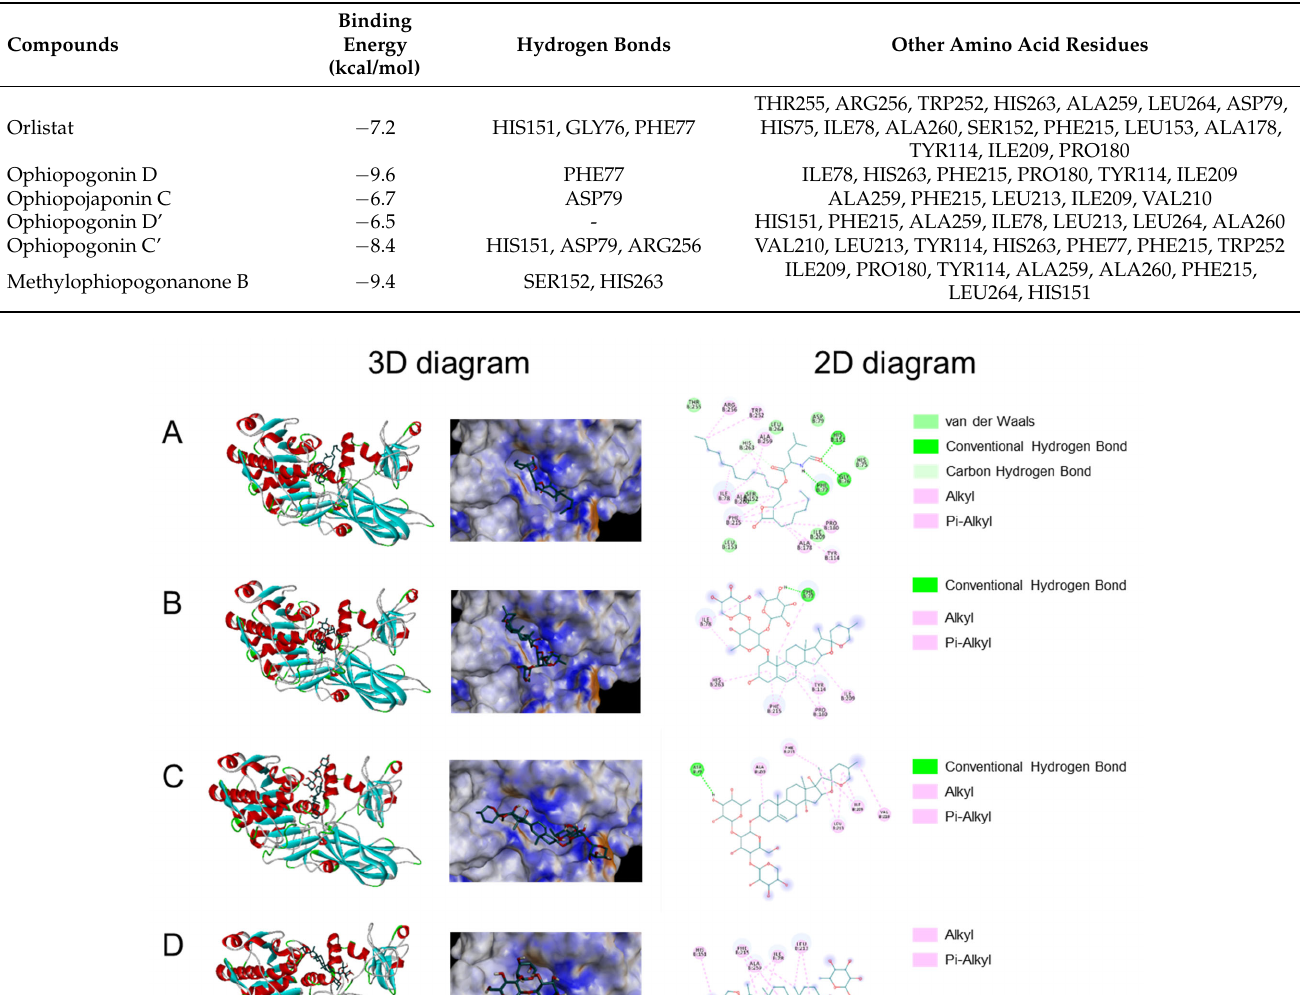
Table 1. Molecular docking results of lipase and the identified active compounds.